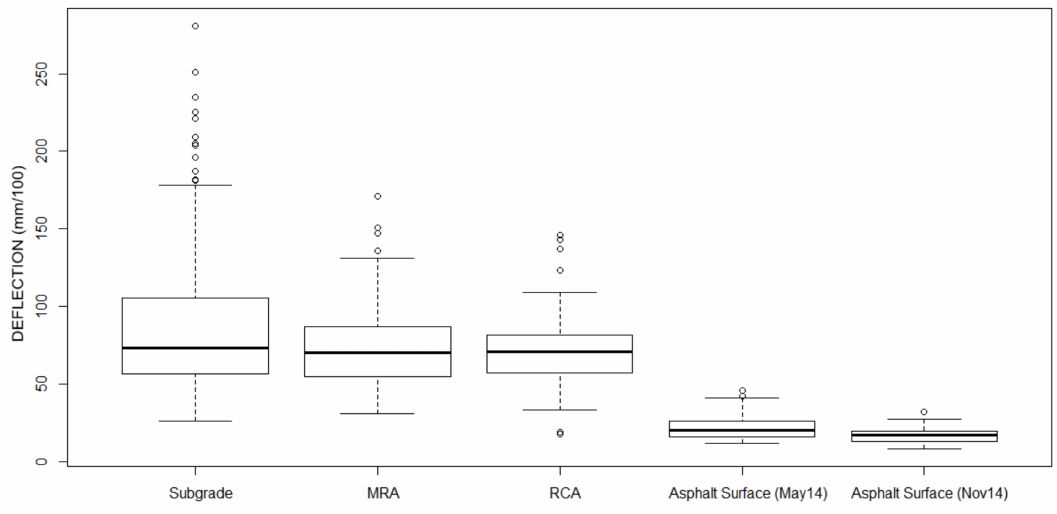
Figure 10. Boxplots showing deflection measurement in di ff erent layers.